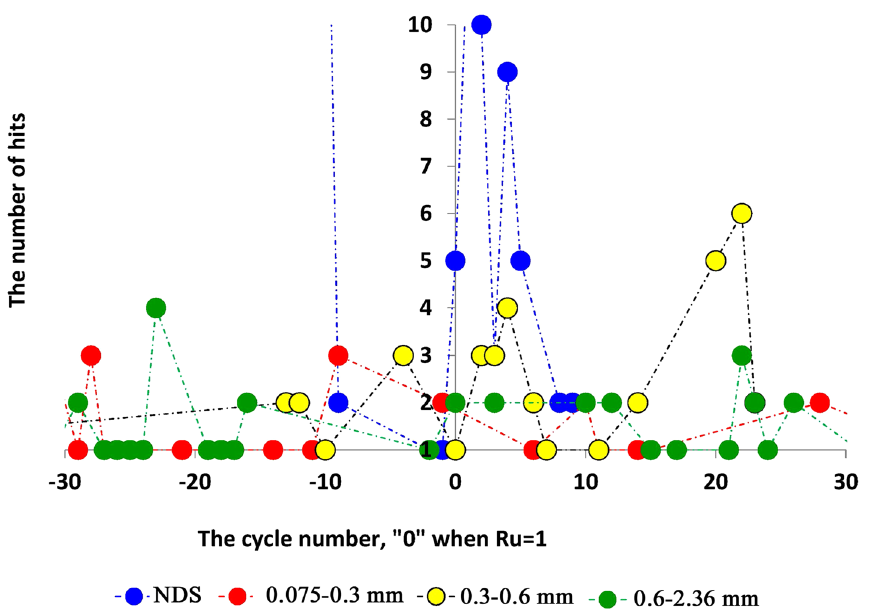
Figure 9. The changes in AE hit number before and after the liquefaction state is created, the X-values is the number of vibration cycles while 0 when the B factor value is reached to 1, the Y-axis is the value of AE hit number. The blue, green, yellow-black, and red circles are for dune sand, fractions 2.36–0.6, 0.6–0.3, 0.3– 0.075 mm,